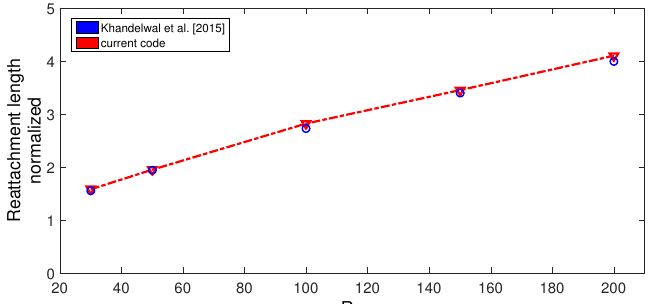
Figure 4. Code validation 2: Average Nu comparisons available in different sources for convective HT in a differentially heated porous cavity at two different Rayleigh numbers.